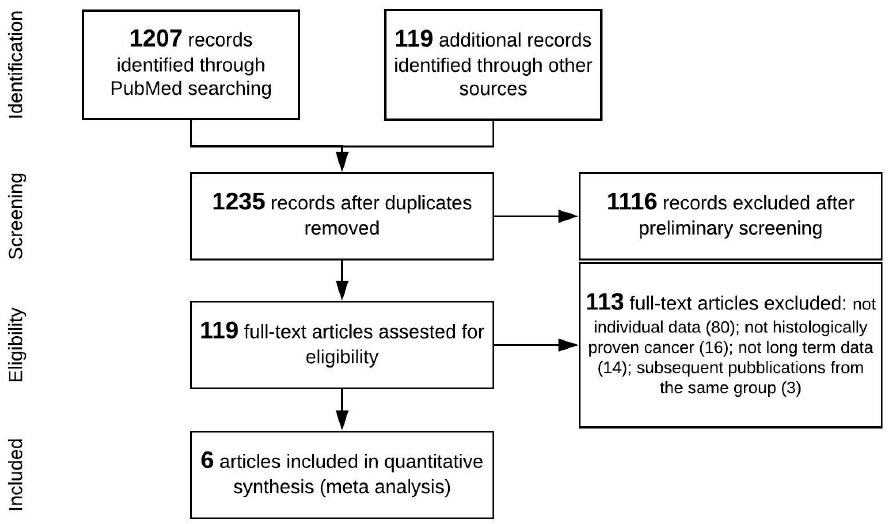
Figure 1. Preferred Reporting Items for Systematic Reviews and Meta-Analyses (PRISMA) flow diagram.